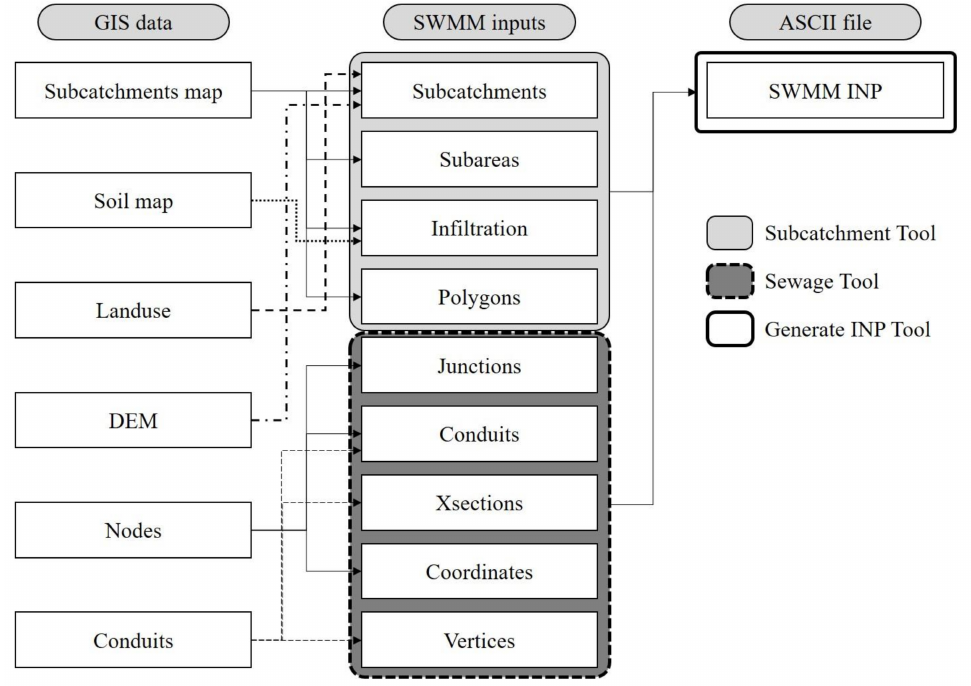
Figure 6. Preparation of SWMM INP file using ArcGIS-based tools developed in this